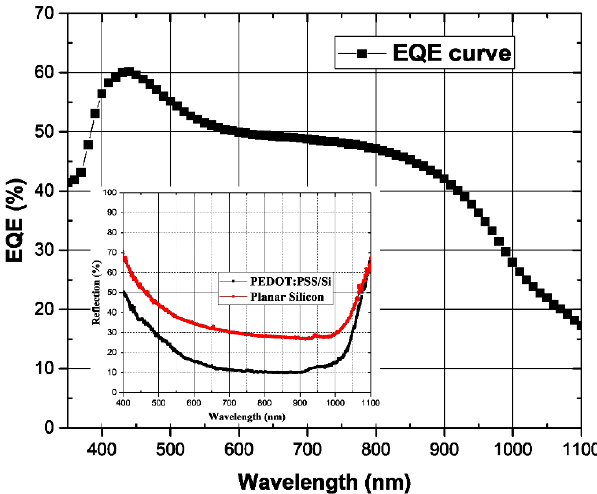
Figure 2. The external quantum efficiency (EQE) spectrum of the HSC device. The inset on the left display reflectance spectra of the planar Si substrate before and after spin coating of the PEDOT: PSS.